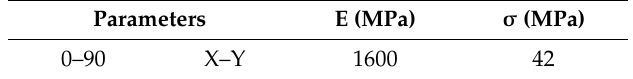
Table 7. Mechanical properties imposed in the virtual testing conditions.